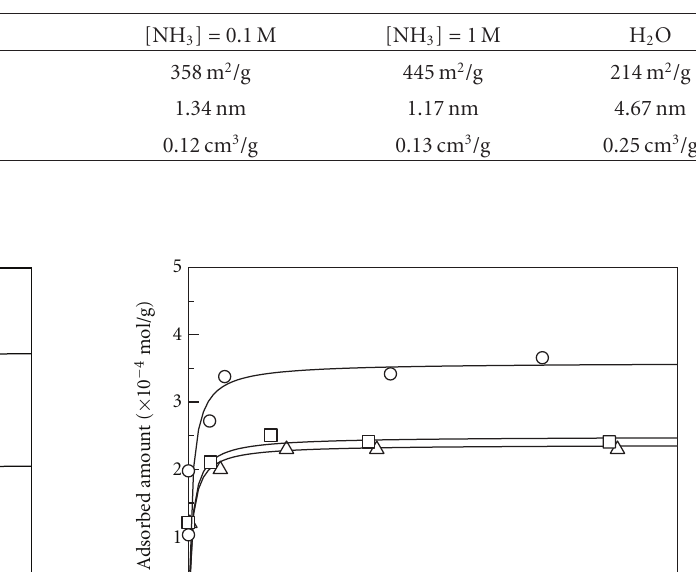
Table 1: The BET specific surface areas of the nanoparticles obtained by heating the mixture of the ethylene glycol solution of TIP and the NH 3 aqueous solution. Average pore diameter and total pore volume were estimated by using the BJH method to the N 2 adsorption isotherms shown in Figure 6.